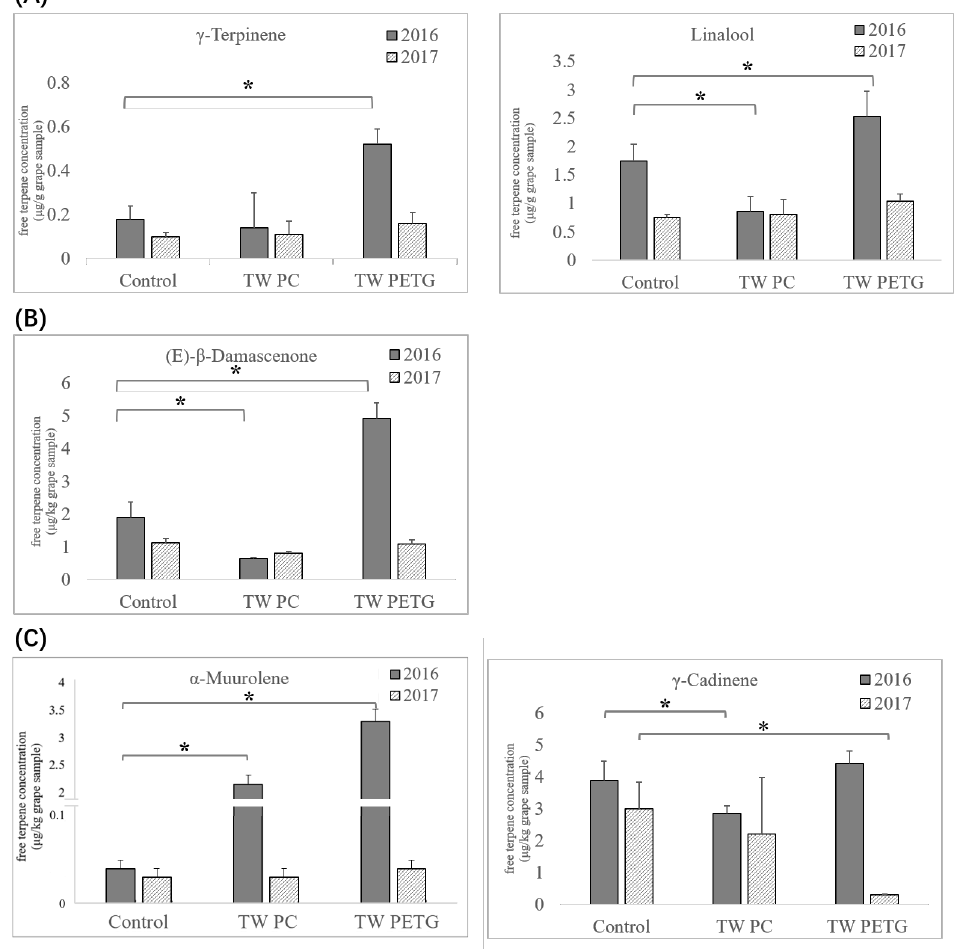
Figure 3. Comparison of key grape terpenes in vintages 2016 and 2017. One-way ANOVA was conducted to compare the concentration of ( A ) free monoterpenes, ( B ) free norisoprenoid and ( C ) sesquiterpene between control and TW treatments. * represents significant difference at p < 0.05.